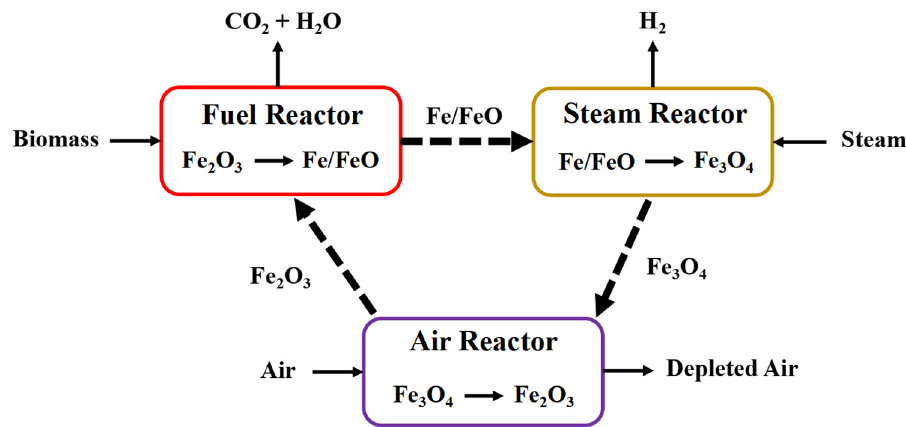
Figure 1. Schematic diagram of biomass direct chemical looping hydrogen generation.